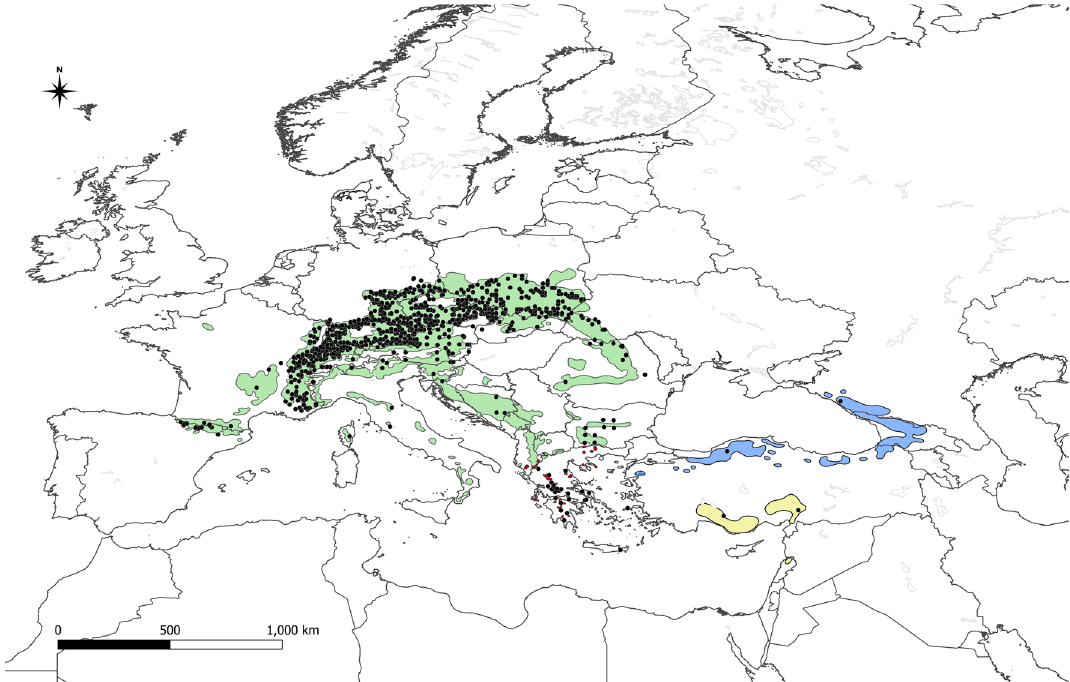
Figure 2. Stands of Viscum album subsp. abietis used in analyses (black dots) and ranges of its hosts. Green— natural range of Abies alba; yellow—natural range of A. cilicica; blue—natural range of A. nordmanniana; red— natural range of A. cephalonica and A. borisii-regis (Caudullo et al. 70 ).